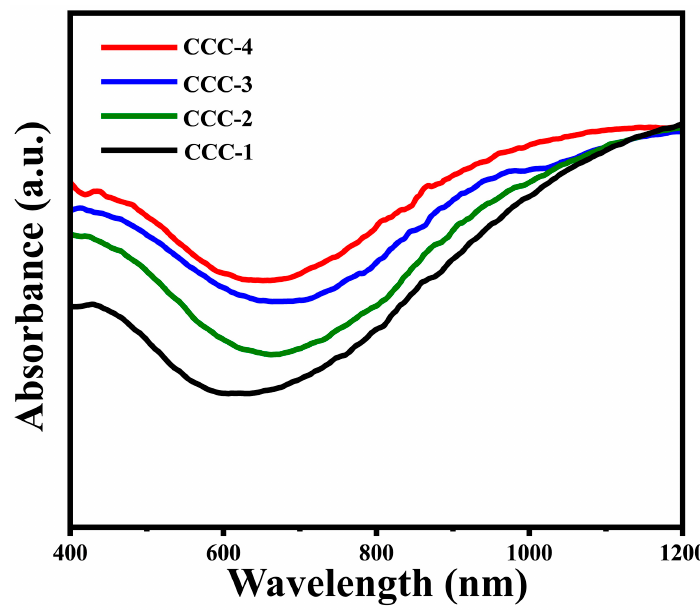
Figure 4. The optical absorbance of CCC-x.